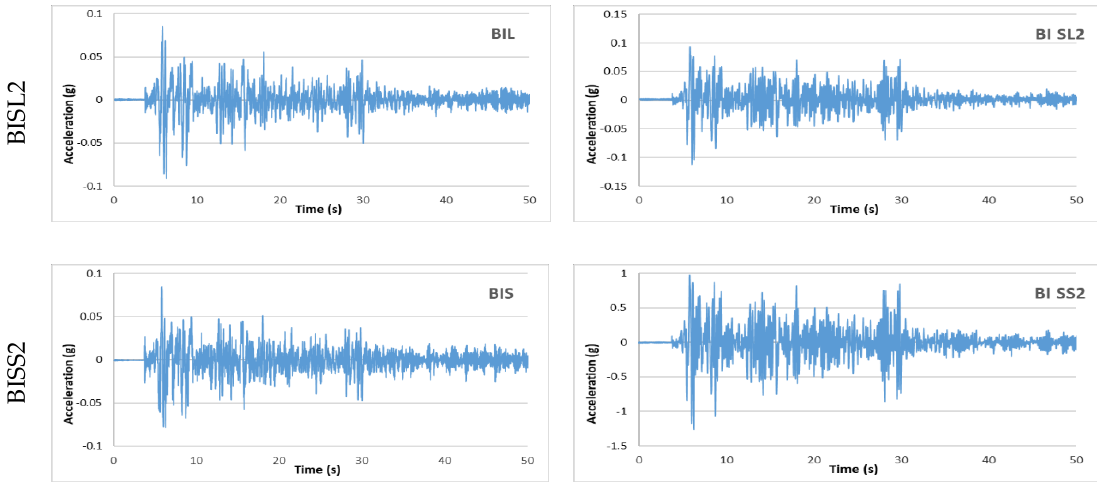
Figure 6. Responses of individual base-isolated models subjected to earthquake excitation.